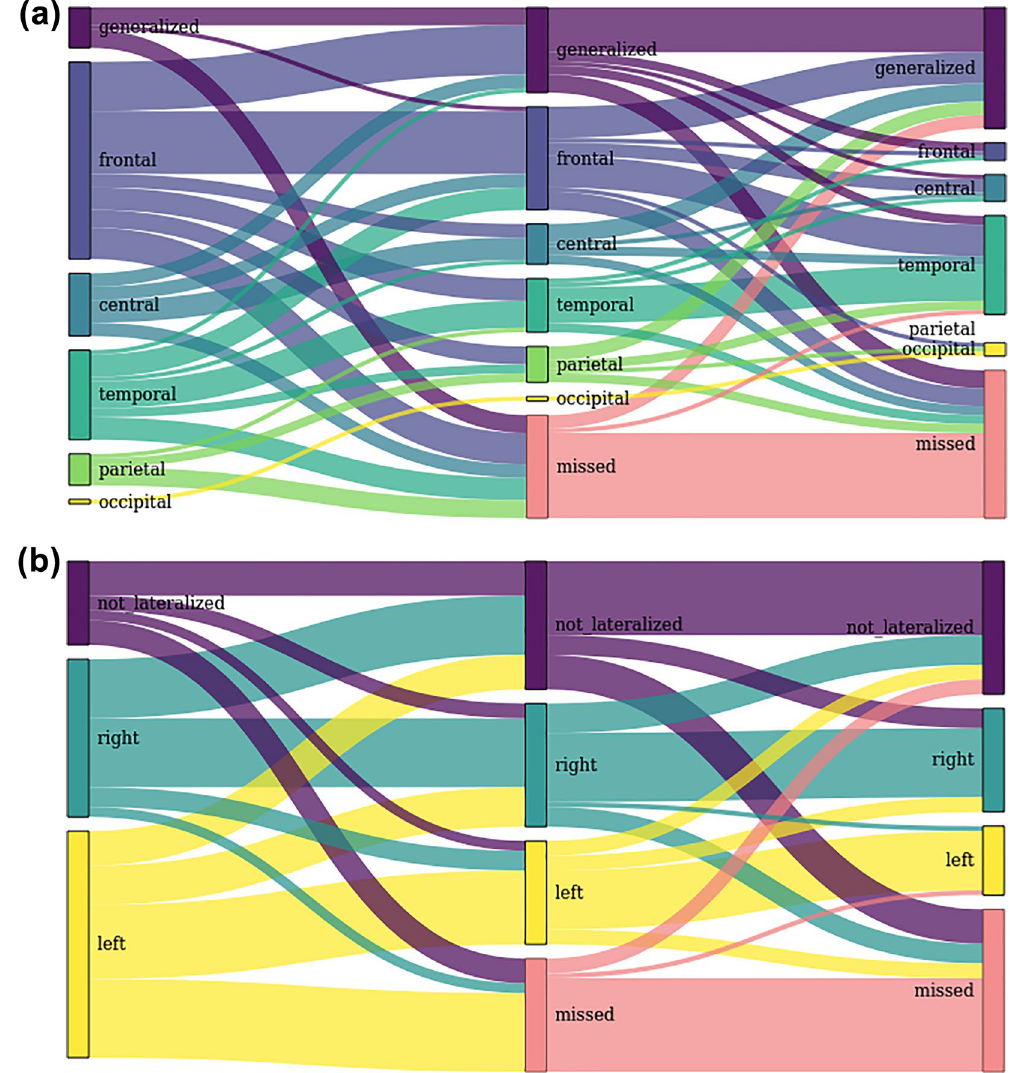
Figure 3. Sankey diagram depicting differences between the localizations and lateralizations of the epileptic seizure patterns between the original EMU classifications (left), the assessment of the full EEG montage (middle), and the reduced EEG montage